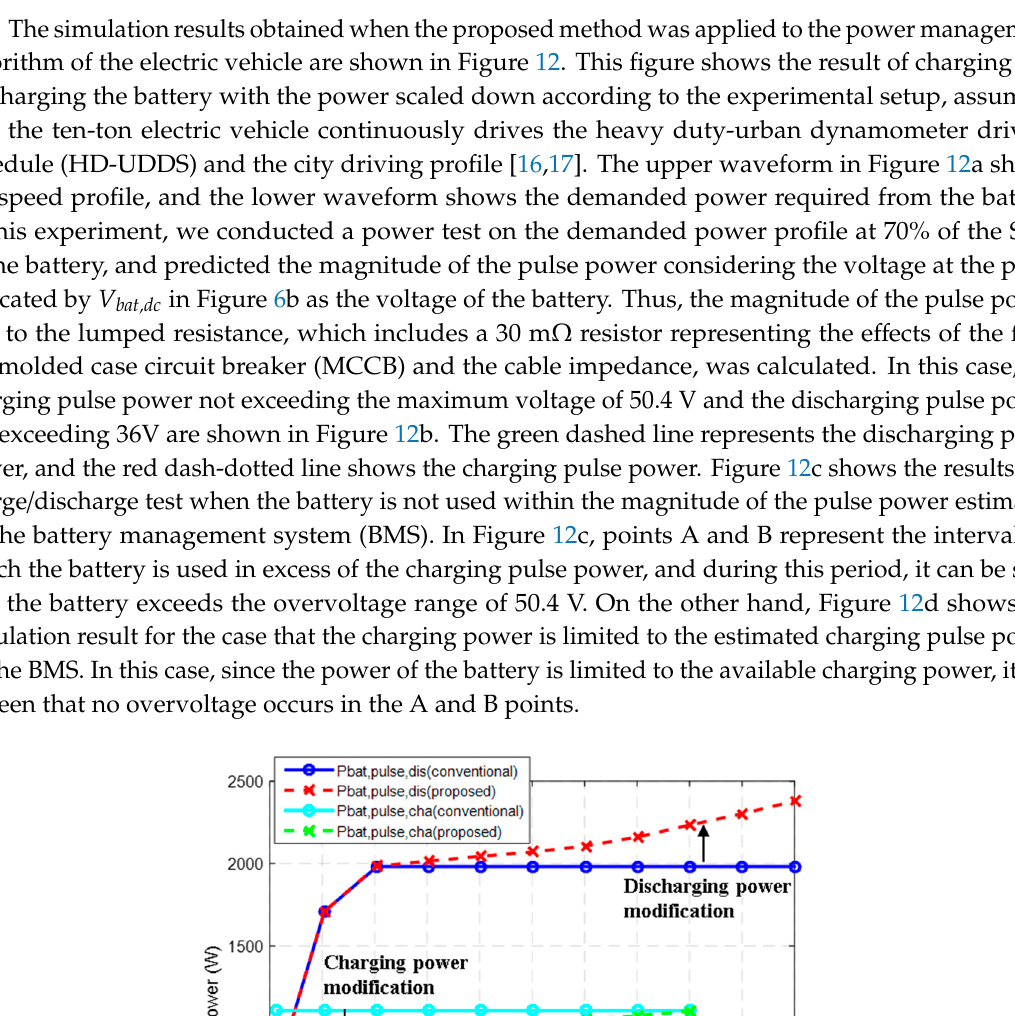
Table 2. Calculated lumped resistance of the battery’s